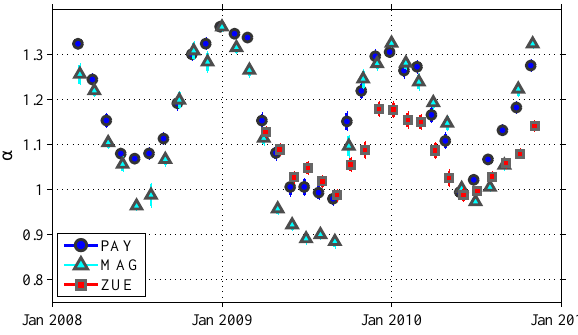
Fig. 1. Time series of the monthly mean ˚Angstrom exponent α at PAY, MAG and ZUE. Vertical lines indicate the uncertainty band of the estimated mean